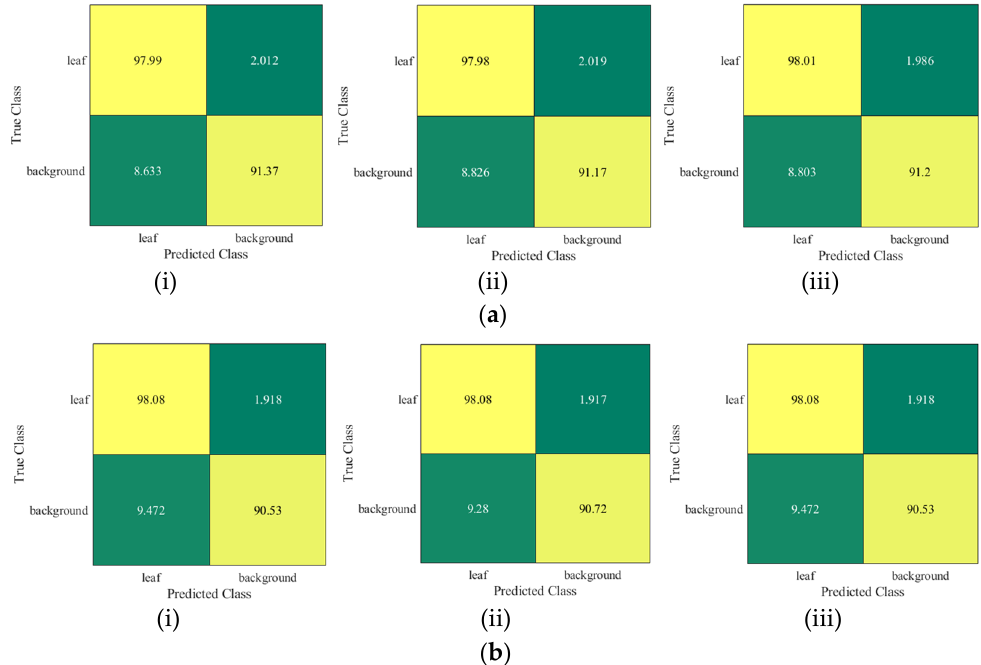
Figure 8. Confusion matrix with training, validation, and testing dataset. ( a ) ThelR547v1 : (i) training performance; (ii) validation performance; (iii) test performance. ( b ) Deeplabv3plusInceptionResNetv2: (i) training performance; (ii) validation performance; (iii) test performance.